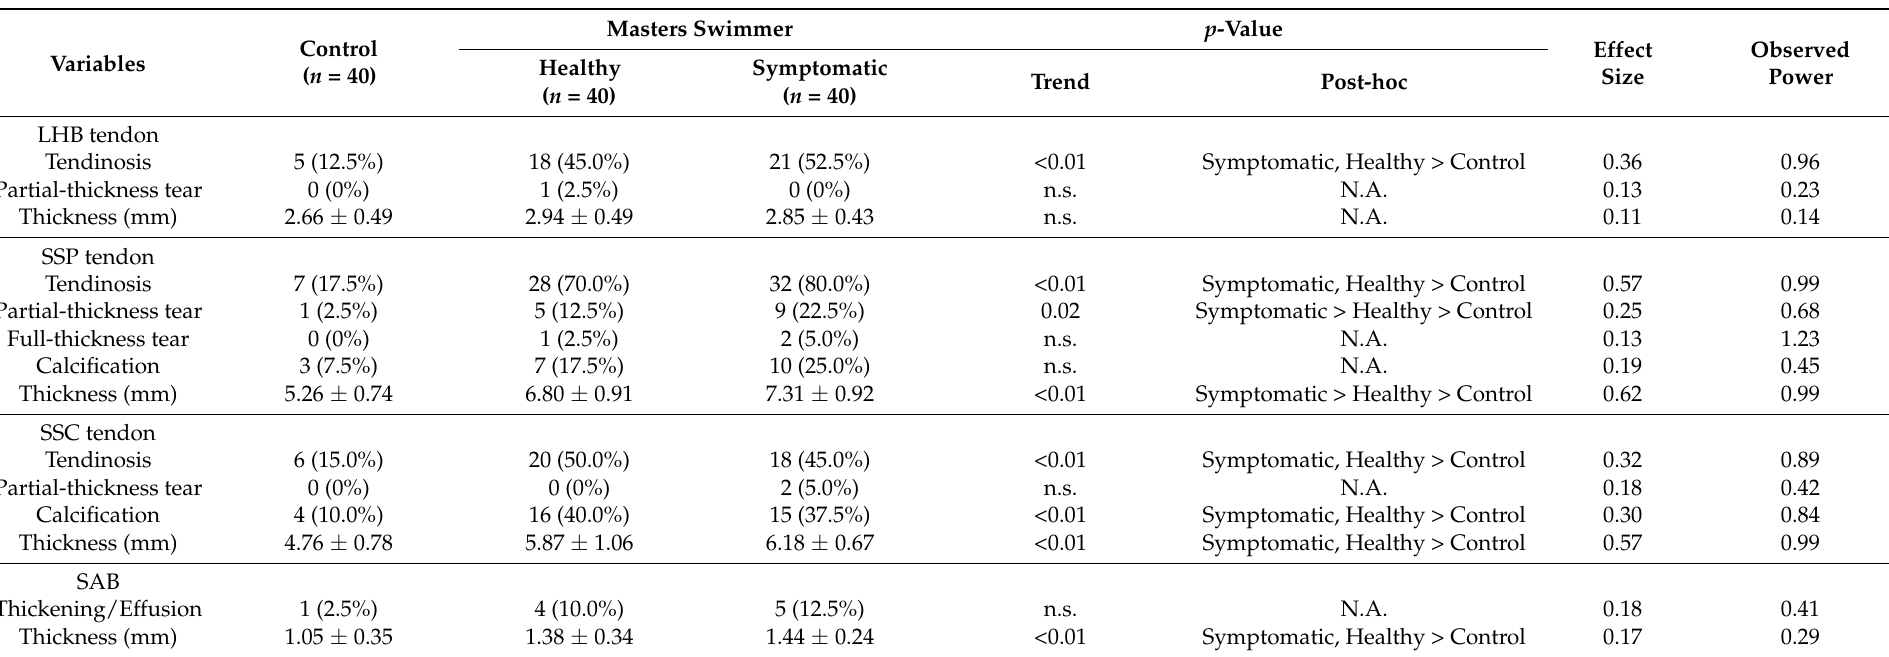
Table 1. Comparison of the prevalence of ultrasonographic findings and rotator cuff thickness between healthy and symptomatic masters swimmers and the control group.